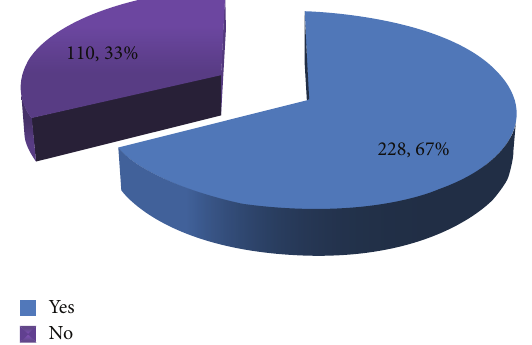
Figure 1: Awareness of respondents about cervical cancer.